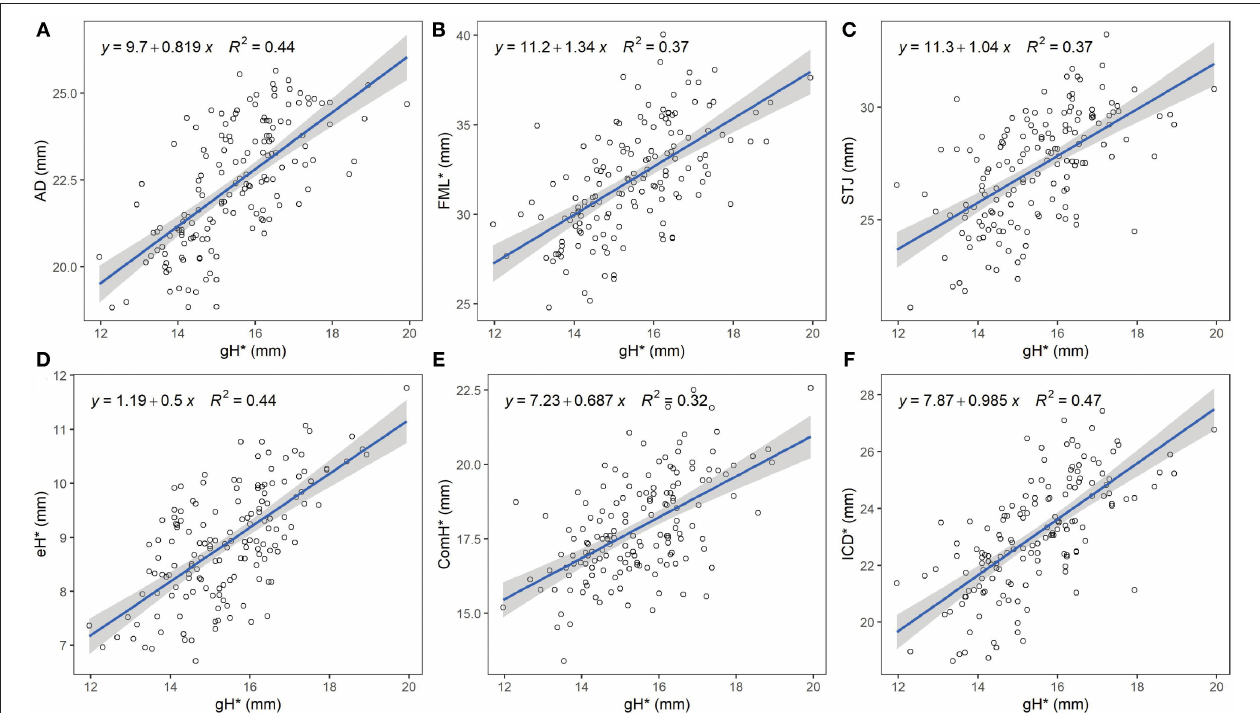
FIGURE 2 | Relationship between geometric height and aortic valve measures. The blue line represents the best fit linear regression model of the data points. The shaded gray area represents the 95% confidence level interval for predictions from each linear model. (A) Linear regression between gH and AD. (B) Linear regression between gH and FML. (C) Linear regression between gH and STJ area-derived diameter. (D) Linear regression between gH and eH. (E) Linear regression between gH and ComH (F) Linear regression between gH and ICD. gH, geometric height; AD, annular diameter; FML, free margin length; STJ, sino-tubular junction; eH, effective